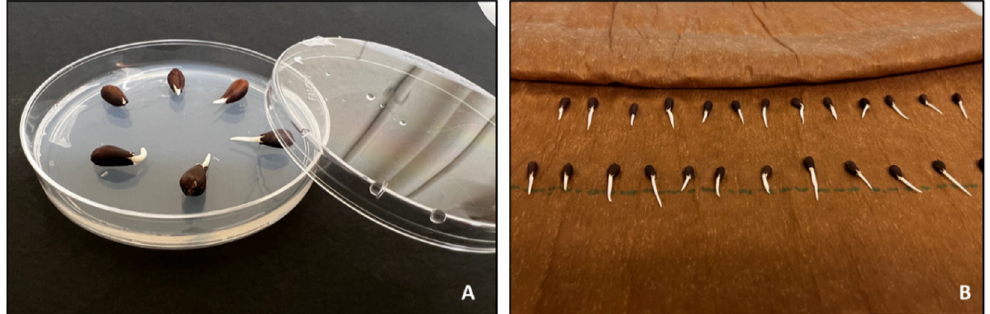
Figure 2. Cotton seed germination in water agar ( A ) versus rolled germinating paper ( B ).